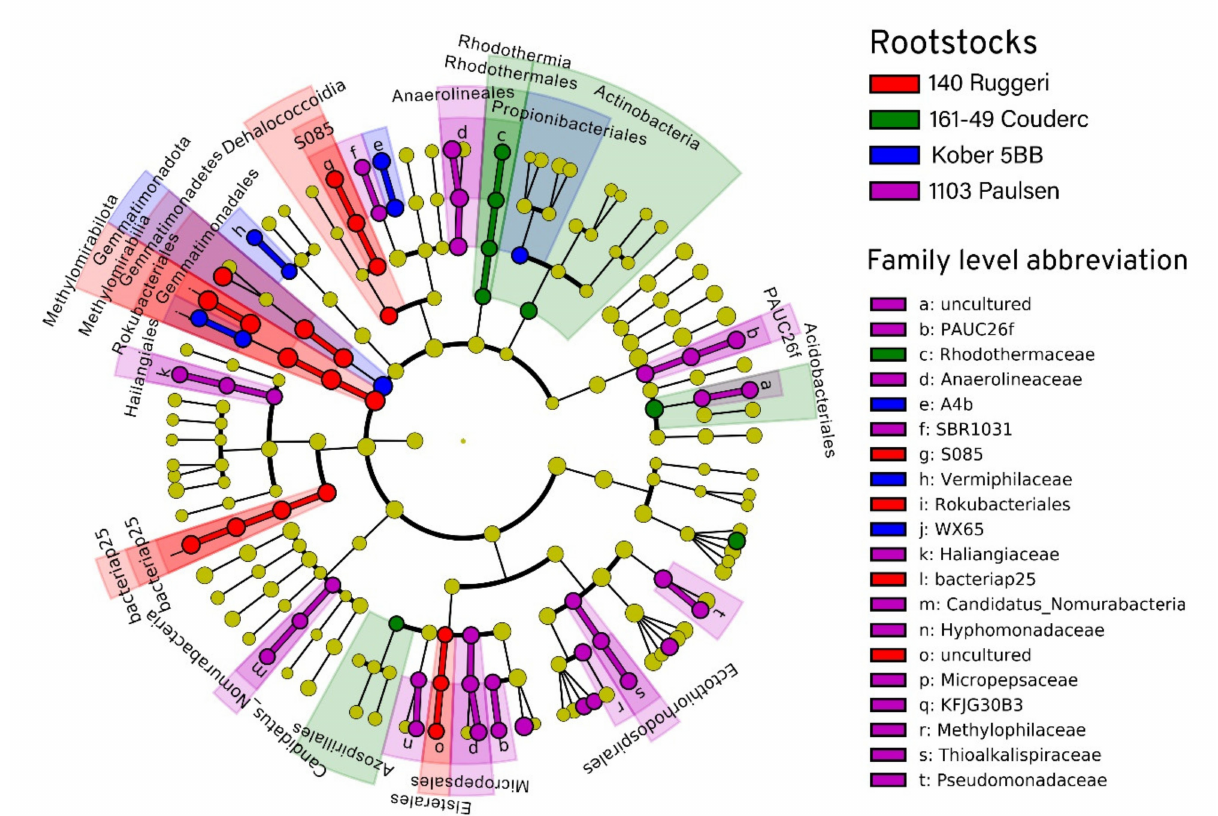
Figure 5. Linear discriminant analysis (LDA) effect size taxonomic cladogram comparing the bacterial diversity of the four rootstocks. Each ring represents a taxonomic level, with kingdom, phylum, class, order, family and genus appearing from the center to the periphery. Each node represents a taxonomic unit found in the dataset. For each significantly discriminating taxon detected, the corresponding node and branch region in the taxonomic cladogram is colored according to the highest ranked group for that taxon. If the taxon is not significantly different between rootstocks, the corresponding node is colored